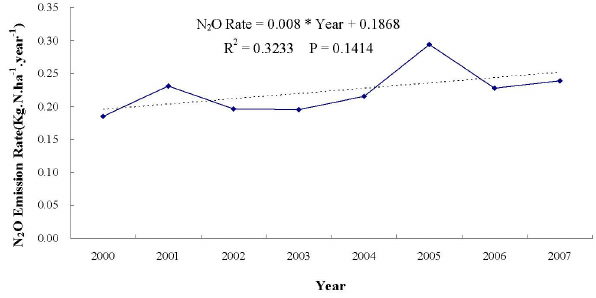
Fig. 6. Chinese grassland N 2 O emission rate yearly changes for